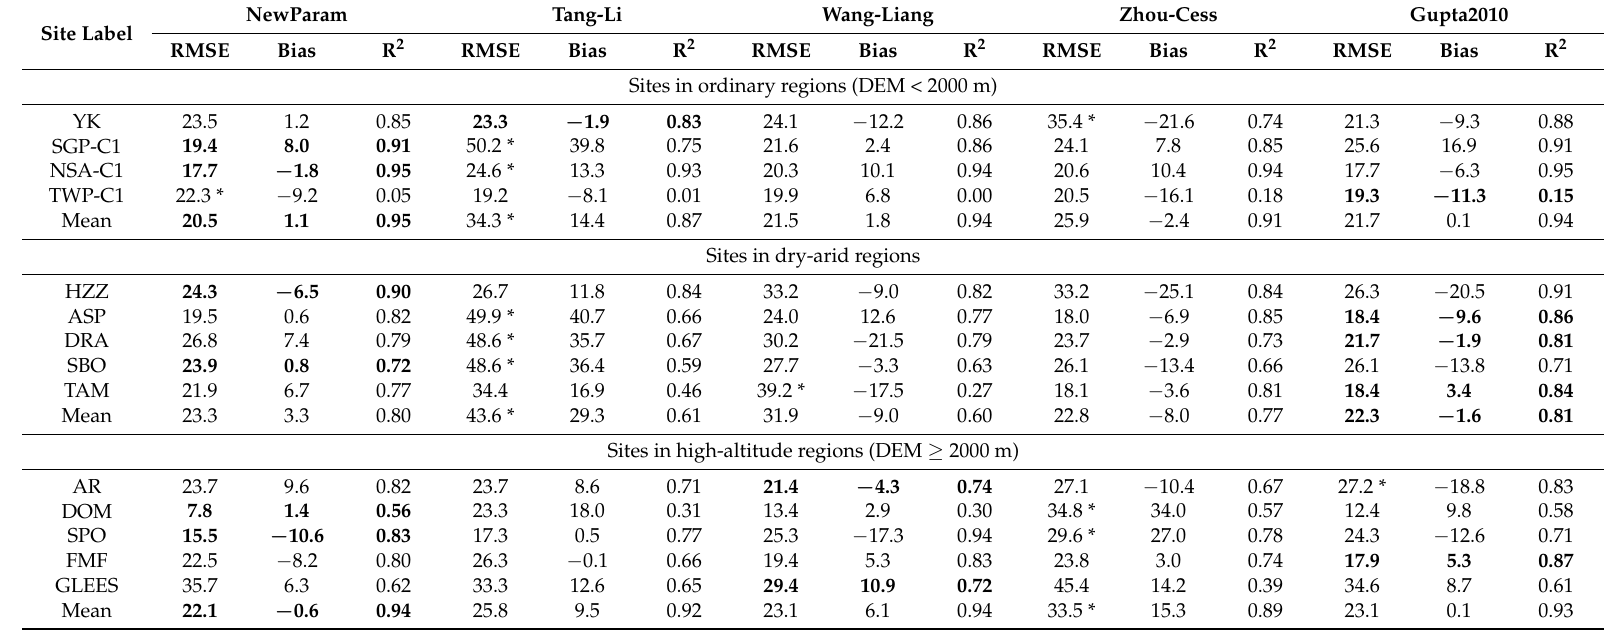
Table 7. Error statistics for MODIS-derived clear-sky DLR using different algorithms. RMSE, bias, and the square of the correlation coefficients (R 2 ) of all sites and the average values of each type of region are given. RMSE and bias are in units of W/m 2 . The best results are highlighted in bold, and the worst results are marked with